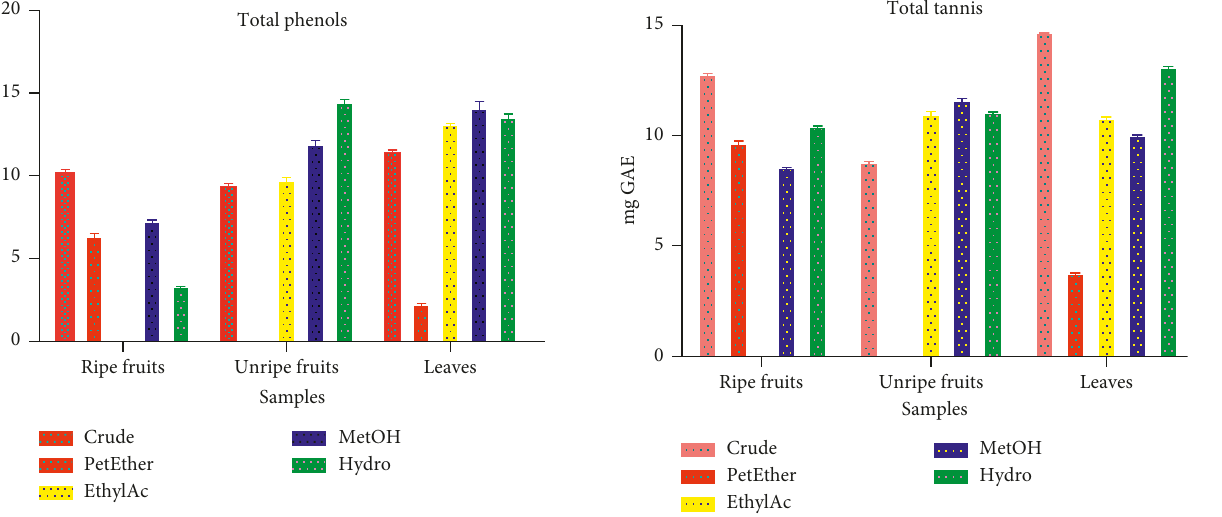
Figure 6: Total tannins content of extract and fractions of D. erecta .